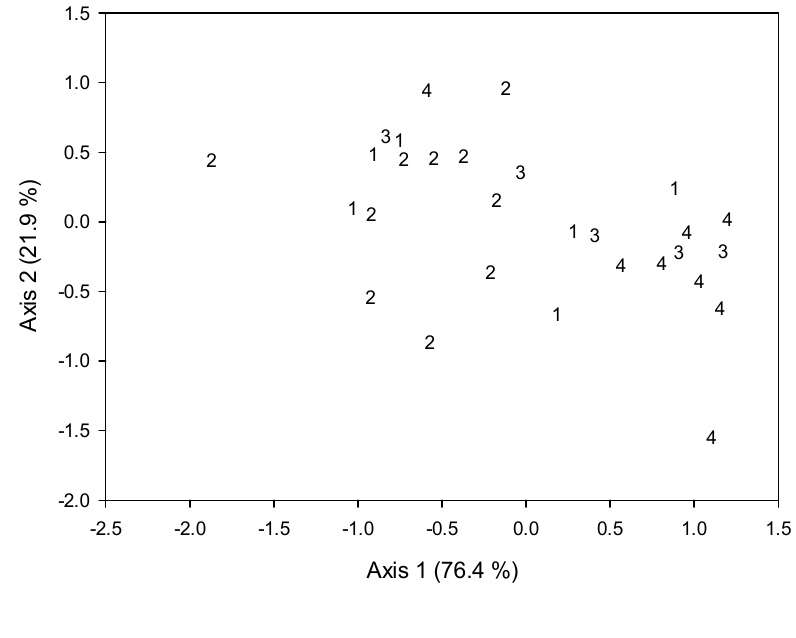
Figure 6. NMDS analysis of monthly trophic composition, with overlay (1–4) representing the four quarters of each year. Proportion (%) of variance explained by each axis is shown. Stress =